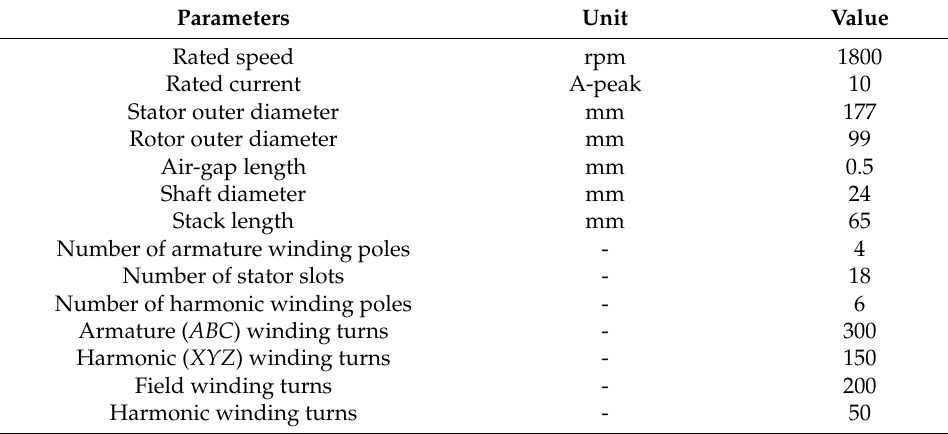
Figure 2. Machine structure showing the four types of windings. Table 1. Machine design parameters.